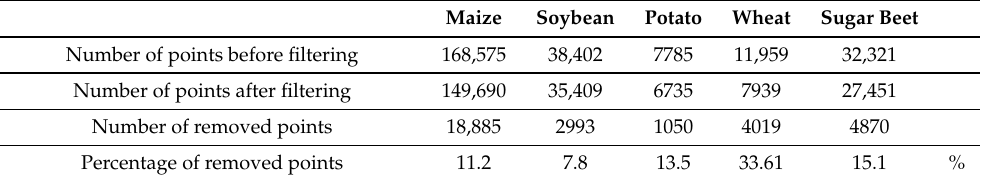
Table 3. Number of points before and after application of the SOR filter for the crop point clouds in Figure 9; number of removed points and the percentage with respect to the unfiltered point clouds; Applied SOR parameter: neighborhood points: k = 20; standard deviation multiplier: q = 0.1. Maize Soybean Potato Wheat Sugar Beet Number of points before filtering